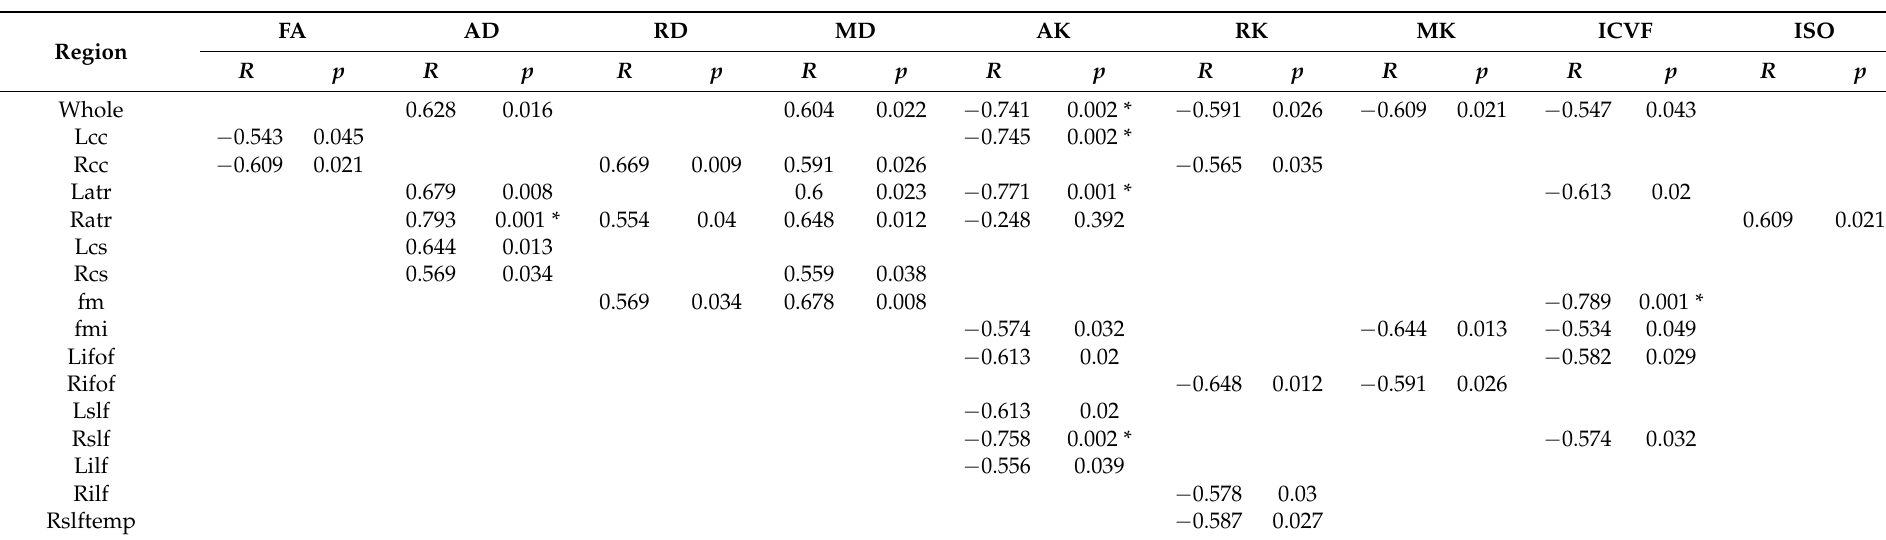
Table 3. Association of completion time of Trail-making test A with tracts-of-interest on DTI, DKI, and NODDI between NSTLC and LTLC groups.